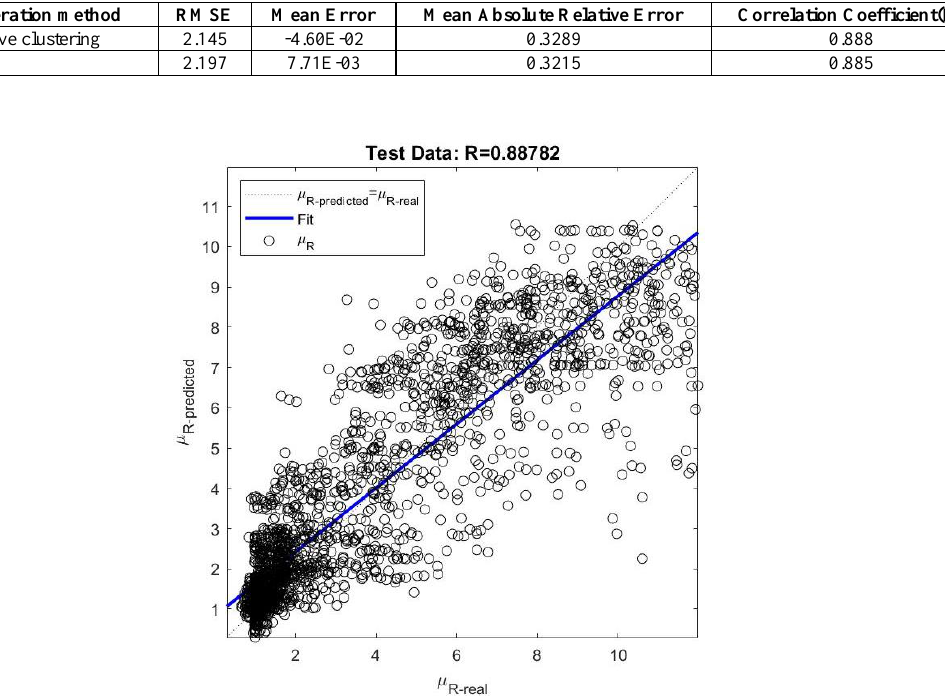
Figure 15. Correlation between the real and predicted values in training data (Subtractive clustering